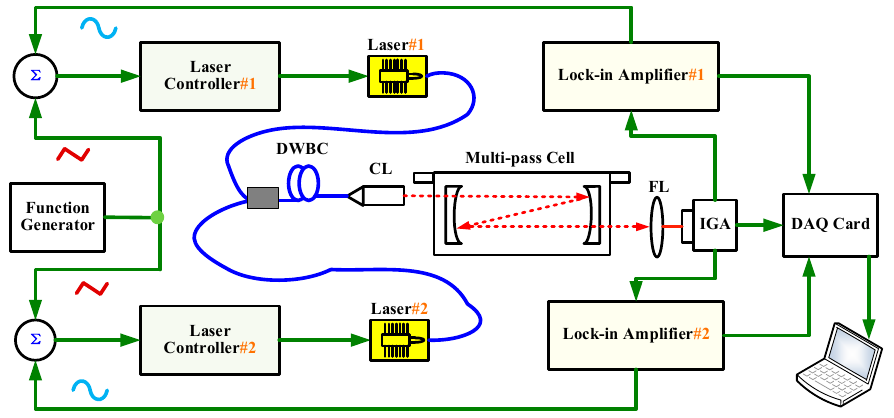
Figure 1. Schematic diagram of the dual-gas sensor. Laser #1 and #2: lasers for CH 4 /C 2 H 6 ; DWBC: single mode standard coupler; CL: collimator; FL: focusing lens; IGA: InGaAs detector.